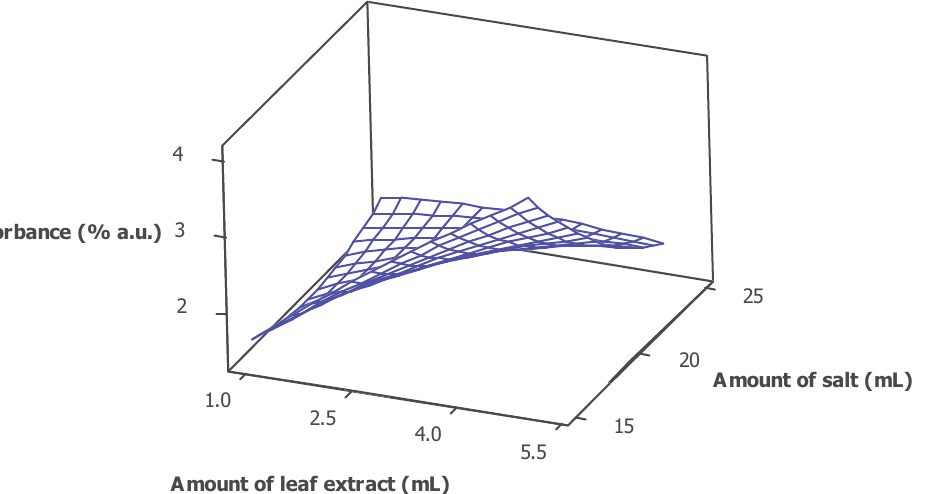
Figure 3: Response surface plot for absorbance of the fabricated Se NP solution as a function of the amounts of walnut leaf extract and selenium salt.